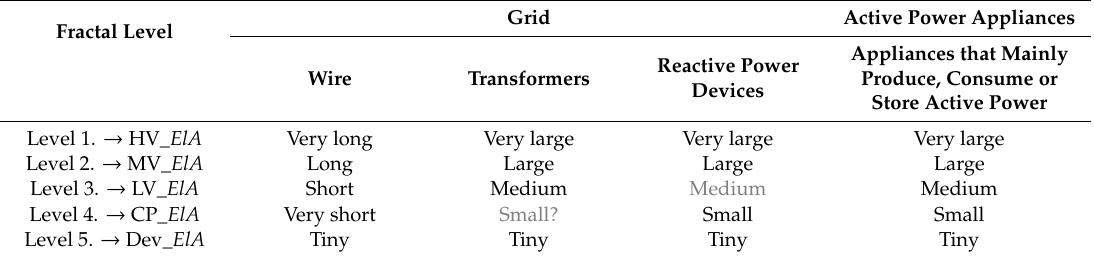
Table 1. The fractal structure of smart grids based on different fractal levels.